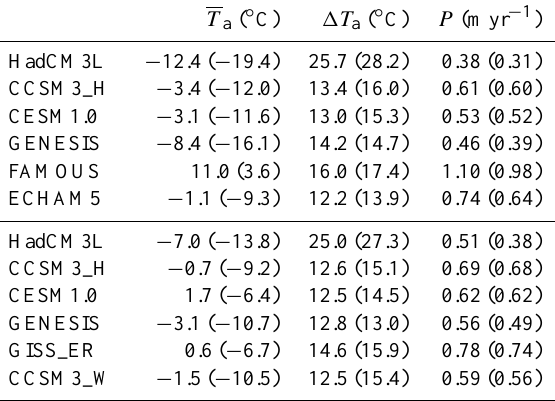
Table 2. Climate variables passed to the ISM from GCM simula- tions, shown as averages over the East Antarctic continent, with av- erages at elevations above 1500 m in parenthesis. ¯ T a is the annual mean air temperature, ∆ T a is the annual air temperature half range (difference between the warm month and the annual mean temper- ature) and P is total annual precipitation. For 2 × PIC (upper rows) and 4 × PIC (lower rows) simulations